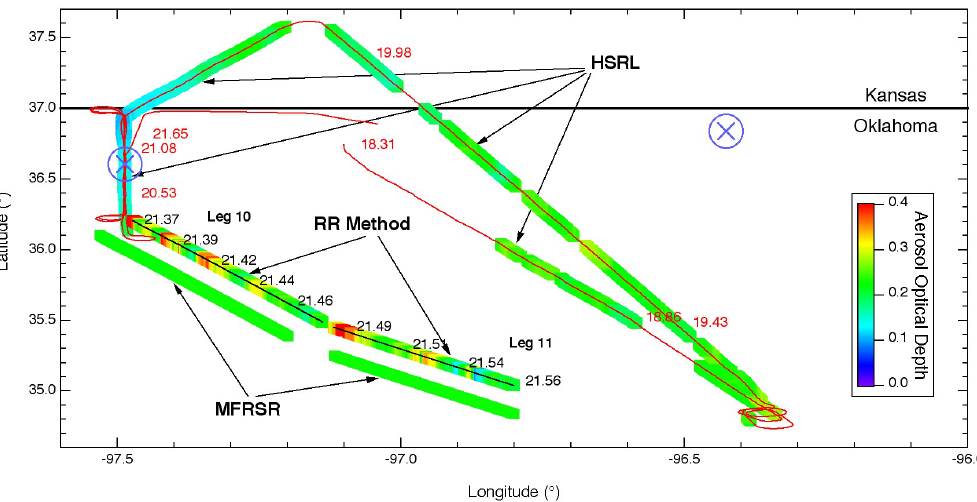
Fig. 9. Map of AOD obtained from the RR, HSRL and MFRSR retrievals (colored lines). Warmer colors indicate larger AOD. The RR retrieval is performed for the MAS-measured reflectances along the MAS flight legs 10 and 11. The more western RR retrieval corresponds to the flight leg 10. Numbers along the colored lines denote the corresponding time of day (UTC) and circles define locations of two MFRSRs. The MFRSR-derived AOD is interpolated spatially and temporally to represent the AOD along the MAS flight trajectory (legs 10 and 11). To ease the comparison of the RR- and MFRSR-derived AODs, the latter are slightly shifted down and to the left (toward the southwest).